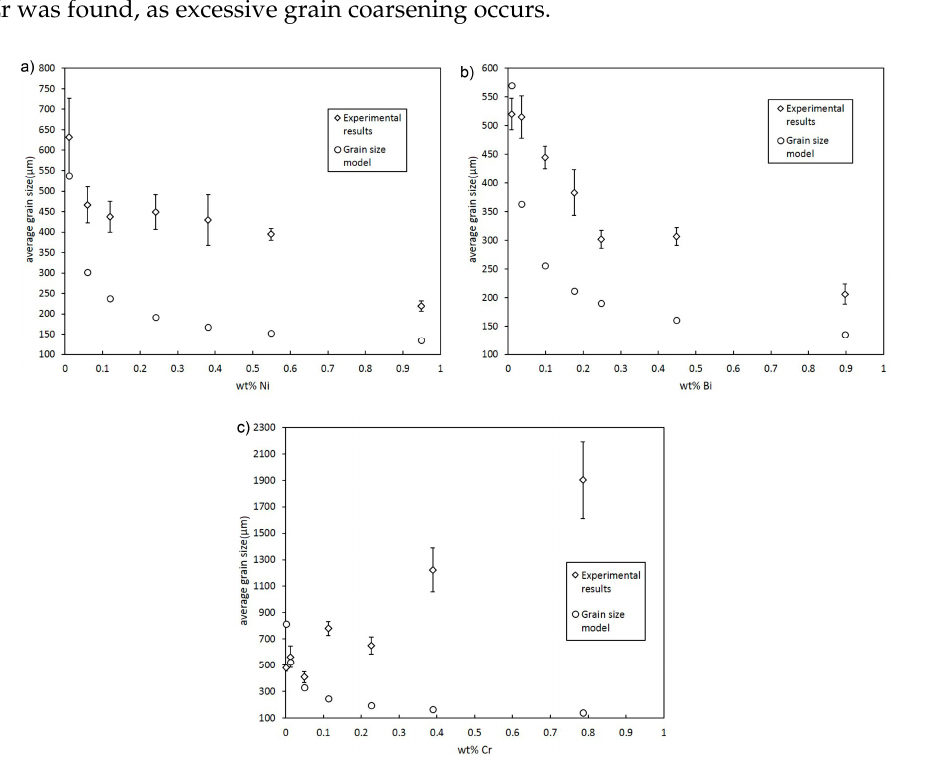
Figure 3. Grain size of Cu with various levels of Ti ( a ), Zr ( b ) and Te ( c ).